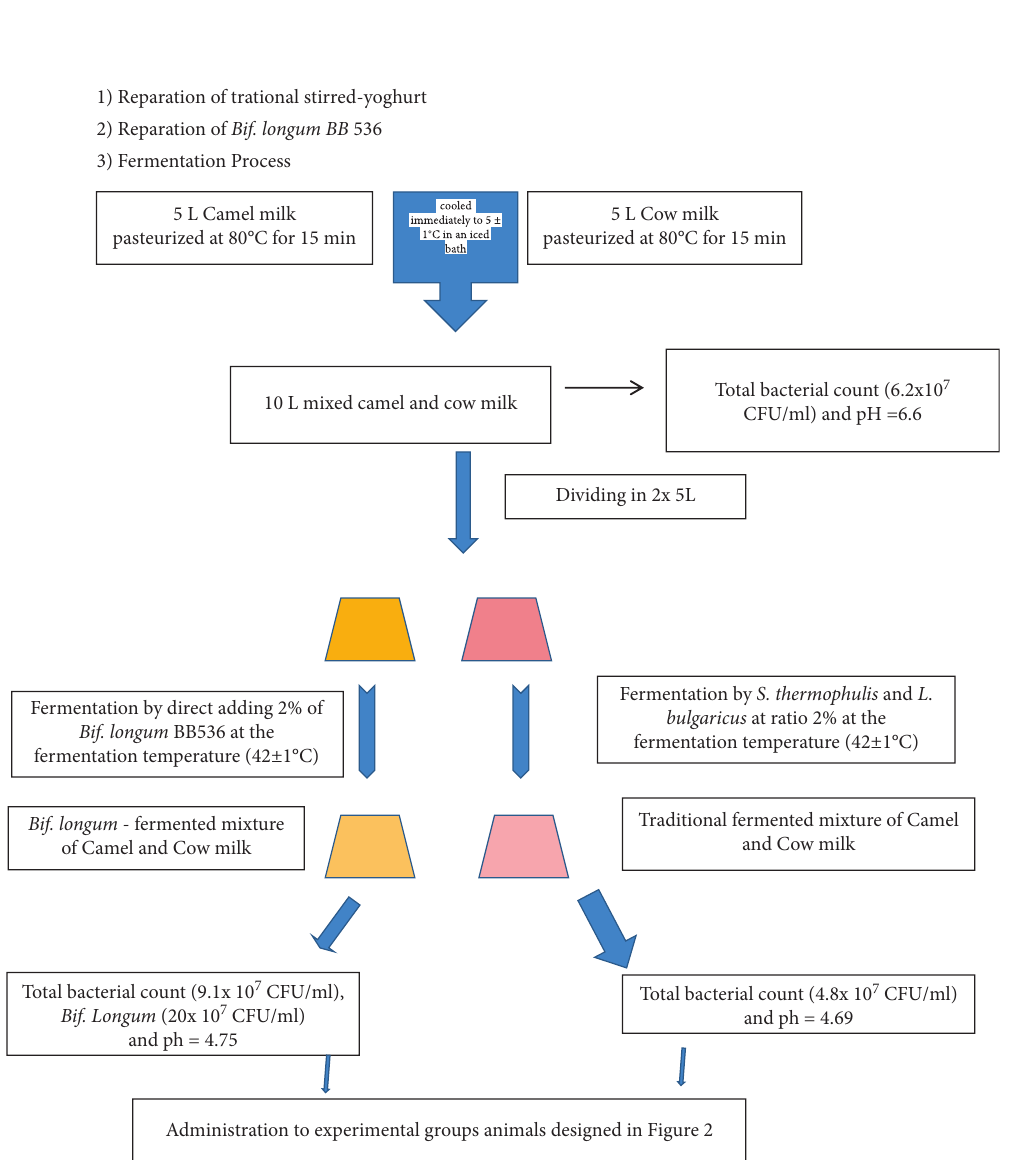
Figure 1: The basic process for making Bifidobacterium longum BB536-fermented mixture of camel and cow’s